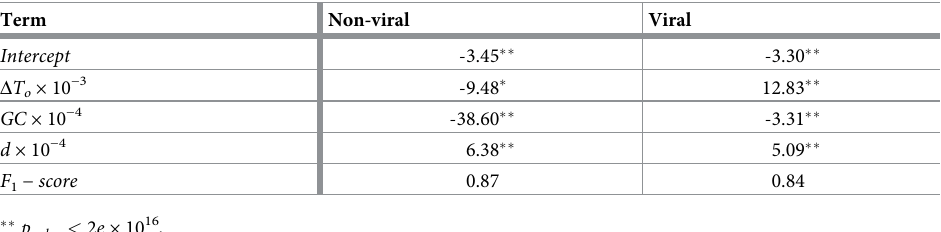
Table 4. Logistic regression